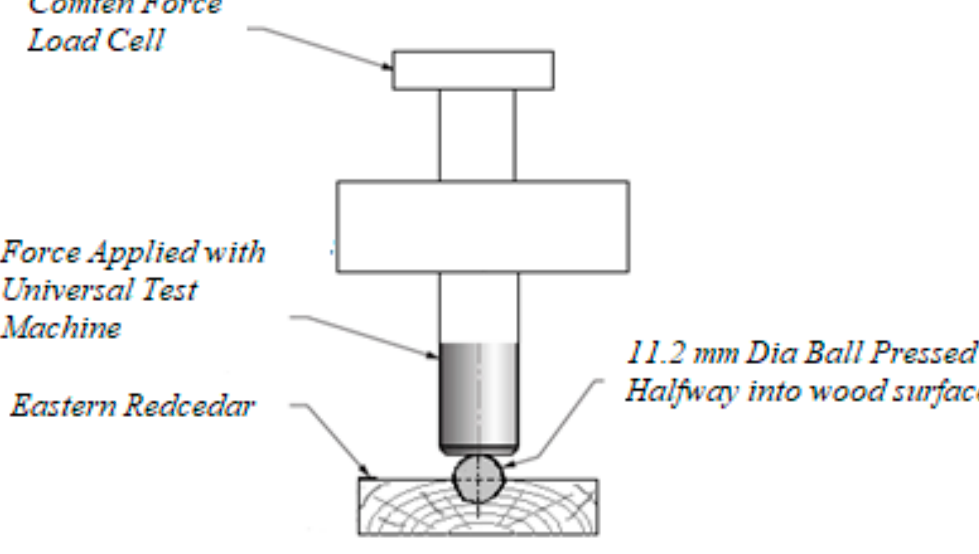
Figure 5. Janka hardness measurement with Comten 95 Series Universal Testing machine.